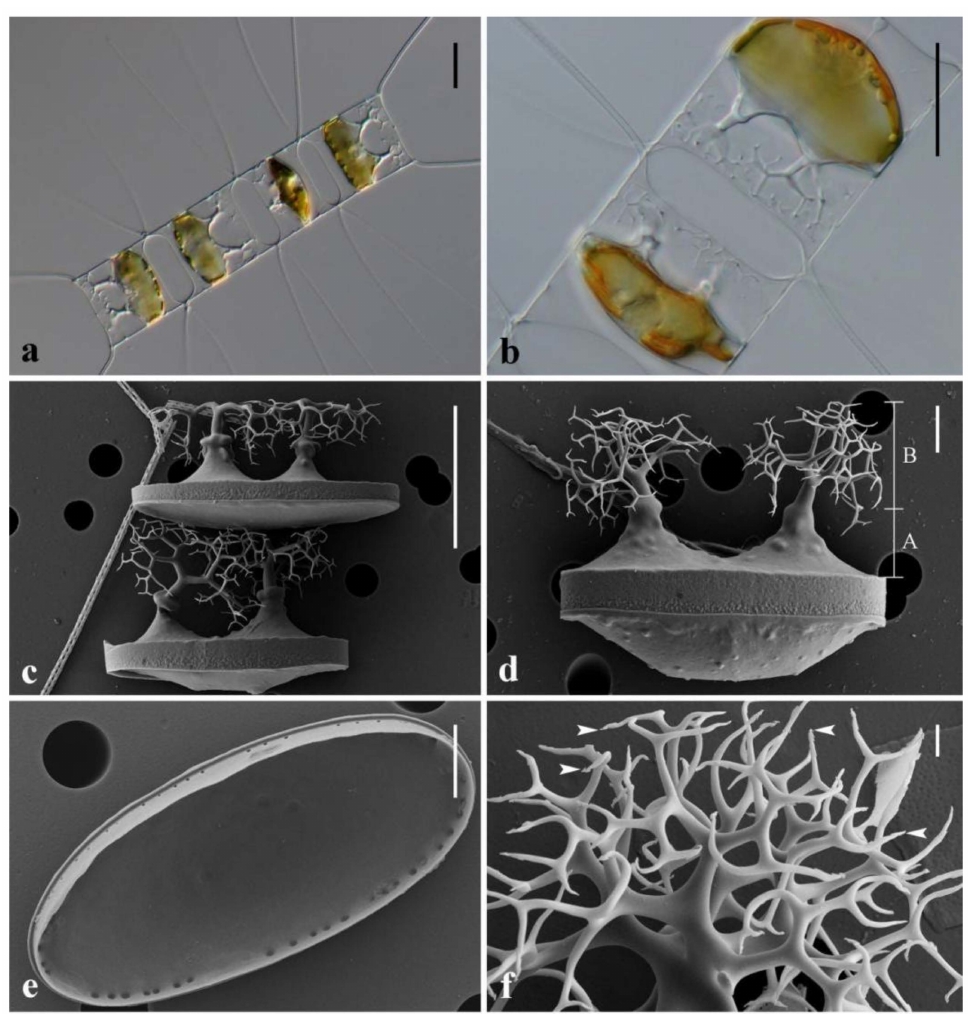
Figure 3. LM ( a , b ) and SEM ( c – f ) micrographs of resting spores of Chaetoceros macroelegans sp. nov., strain MC785. ( a , b ) Resting spores within mother cells; ( c , d ) released resting spores, showing two elongated elevations with dichotomous branching processes distally on the primary valve; A—height of elevation, B—height of branching process; ( e ) internal view of secondary valve; ( f ) hooks on the distal tips (arrowheads). Scale bars: ( a – c ) 20 µ m; ( d , e ) 5 µ m; ( f ) 1 µ